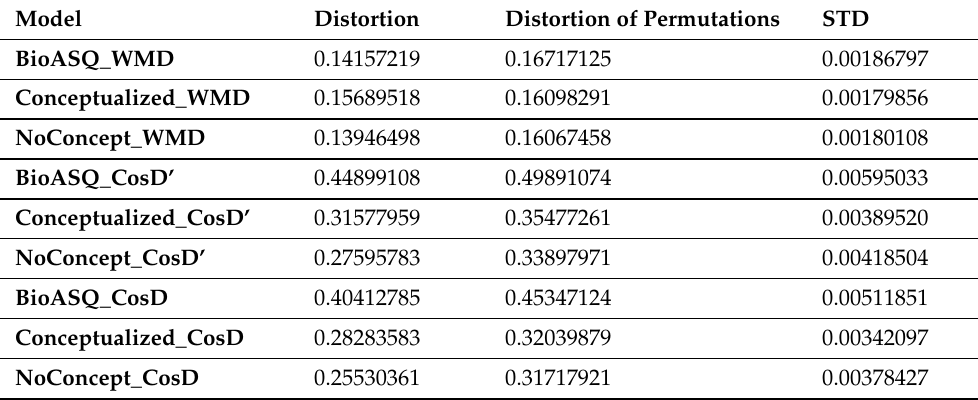
Table A4. The performance of the algorithms on the combined Tables 1 and 2 from [13] is in line with the results in Section 6.2, except for the weaker showing of the Conceptualized_WMD model.